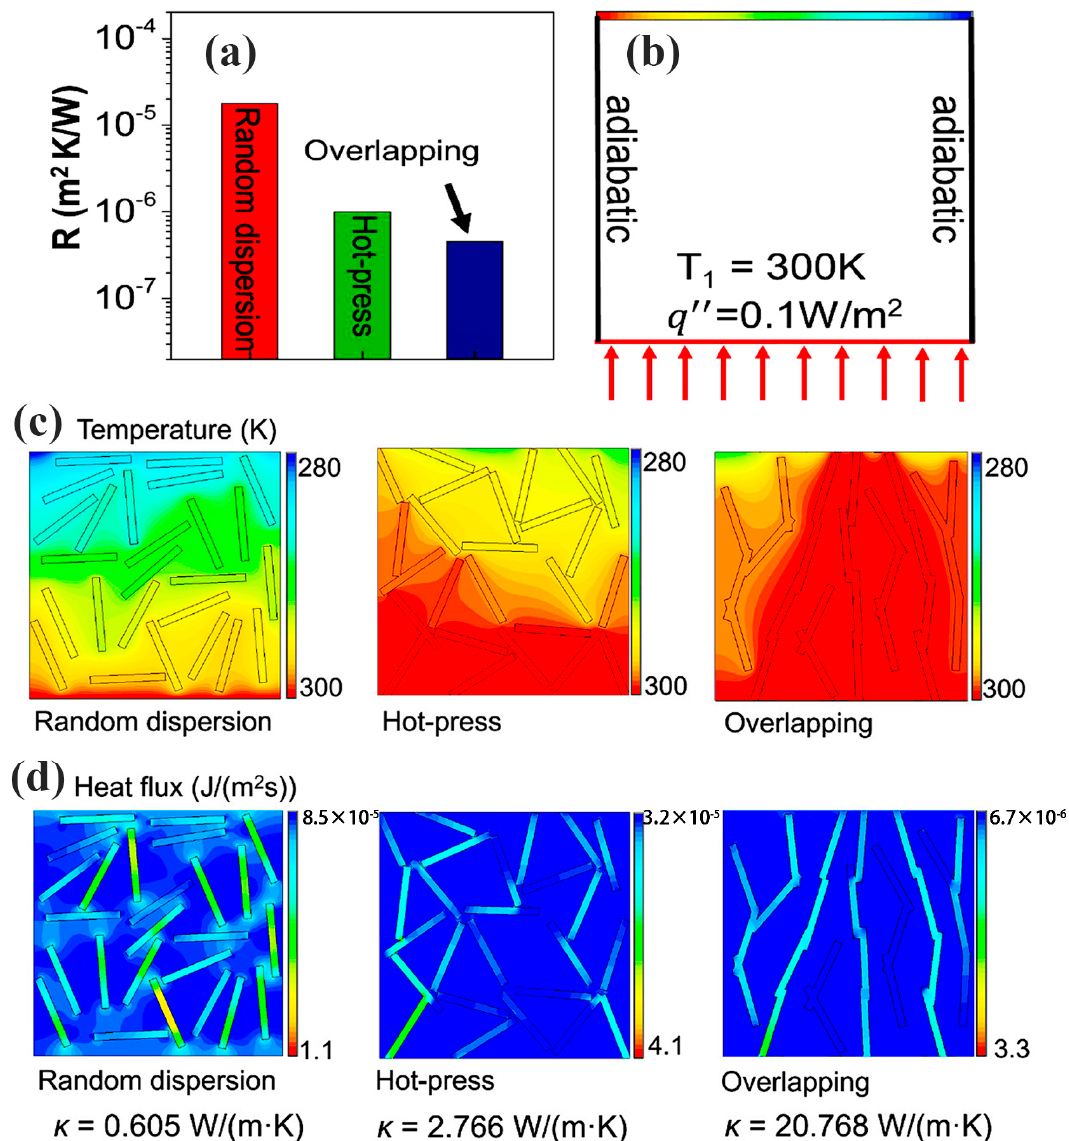
Figure 28. ( a ) Calculated interfacial thermal resistance (R) of three different nanocomposites. ( b ) Boundary conditions of the FE simulation. ( c ) Simulated temperature and heat flux distribution of nanocomposites based on a heat source. ( d ) Simulated heat flux distribution and thermal conductivity of nanocomposites based on a heat source (reproduced with permission from [200]).